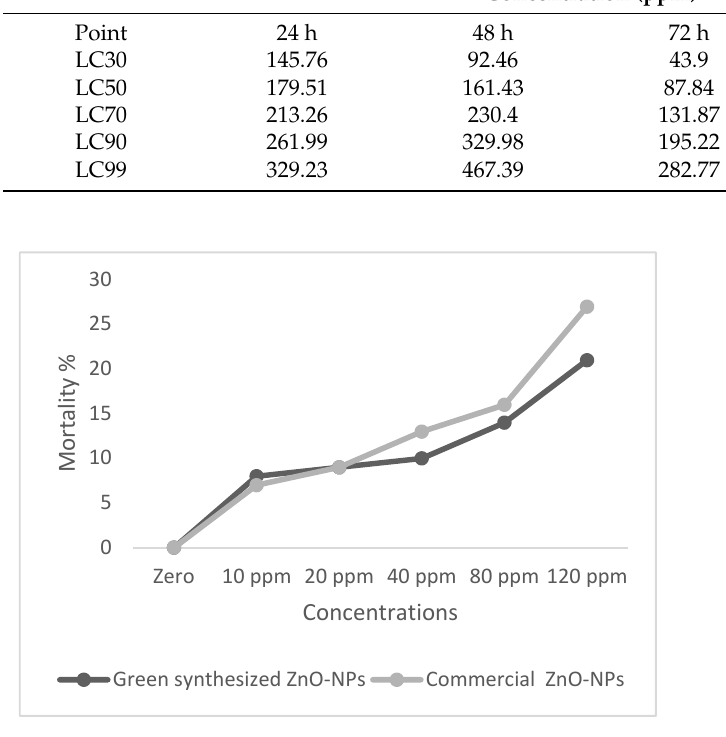
Table 2. Lethal concentrations of green synthesized ZnO-NPs at different time points of 24, 48, 72, and 96 hrs.